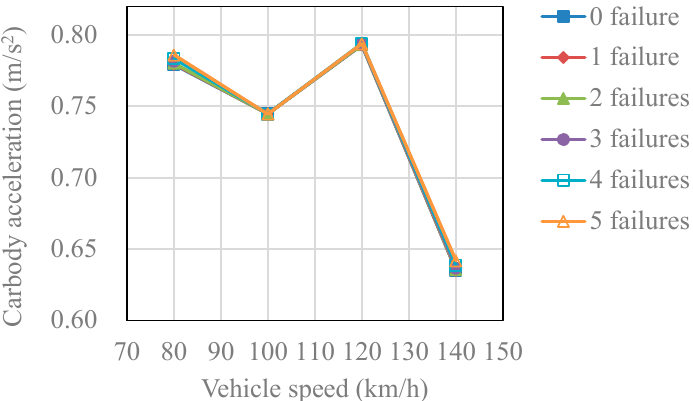
Figure 8. Car body acceleration at different speeds and under different cases.